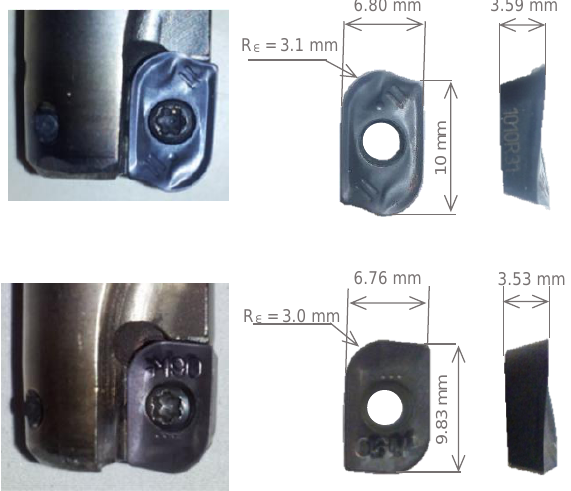
Figure 6. Commercial inserts selected for experimental investigations.